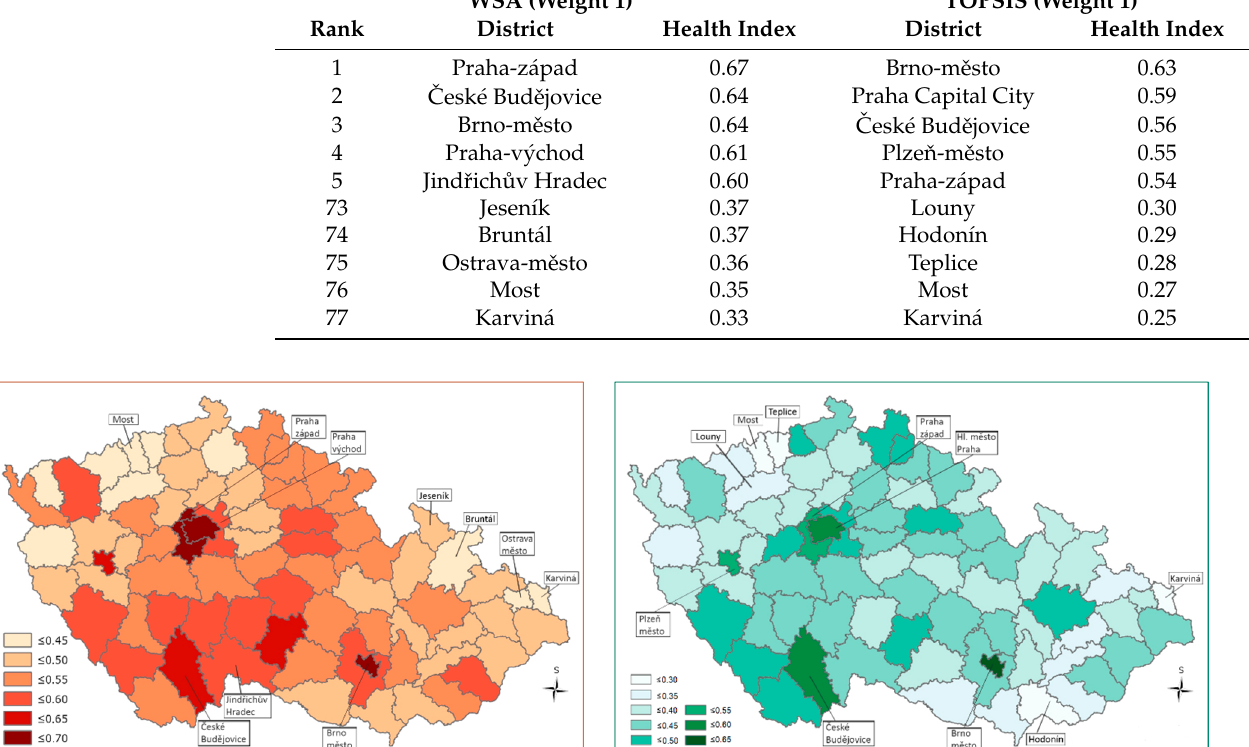
Figure 1. Spatial differentiation of the Health Index values using equal weightings for the different areas—WSA method left side map, TOPSIS right side map 1 . 1 Higher Health Index values are indicated by darker coloring of a district. This also suggests a more favorable situation. Table 2. Health Index values calculated using the WSA and TOPSIS method with equal weightings given to the areas (selection of the best and worst five districts of the Czech Republic).